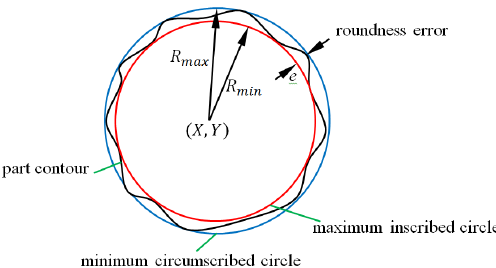
Figure 3. Schematic diagram of the roundness